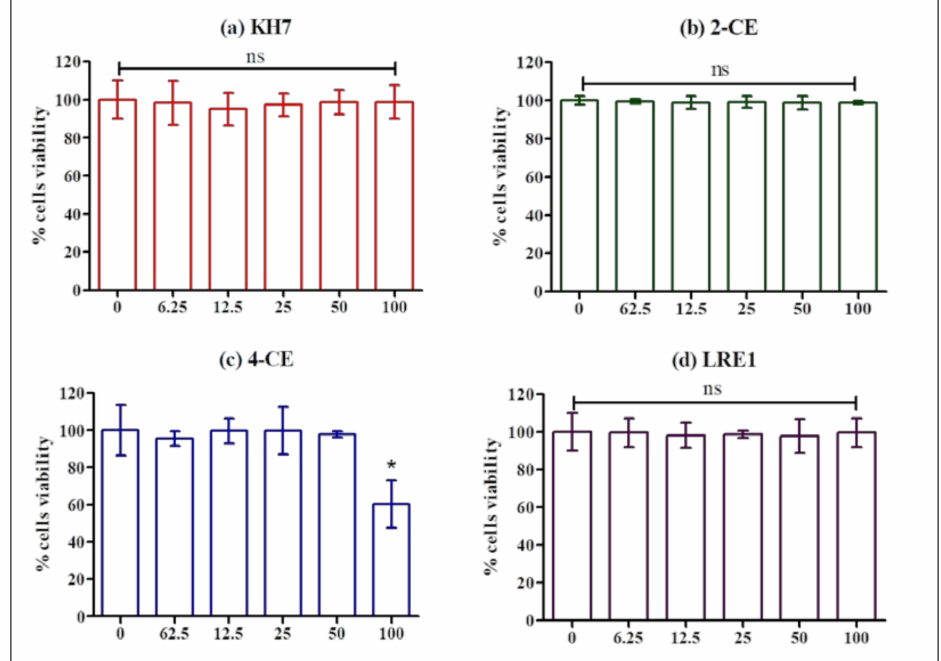
Figure 4. Effect of KH7, 2-CE, 4-CE and LRE1 on the viability of MLTC-1 cells. The viability of MLTC-1 cells was measured after incubation with various concentrations (0, 6.25, 12.5, 50, 100 µ M) of KH7 ( a ), 2-CE ( b ), 4-CE ( c ), or LRE1 ( d ) for 1 h. The experiments were repeated 4 times; values are mean ± SEM. Asterisks indicate significant differences between control (0 µ M) and treatment at p < 0.01; ns: not statistically